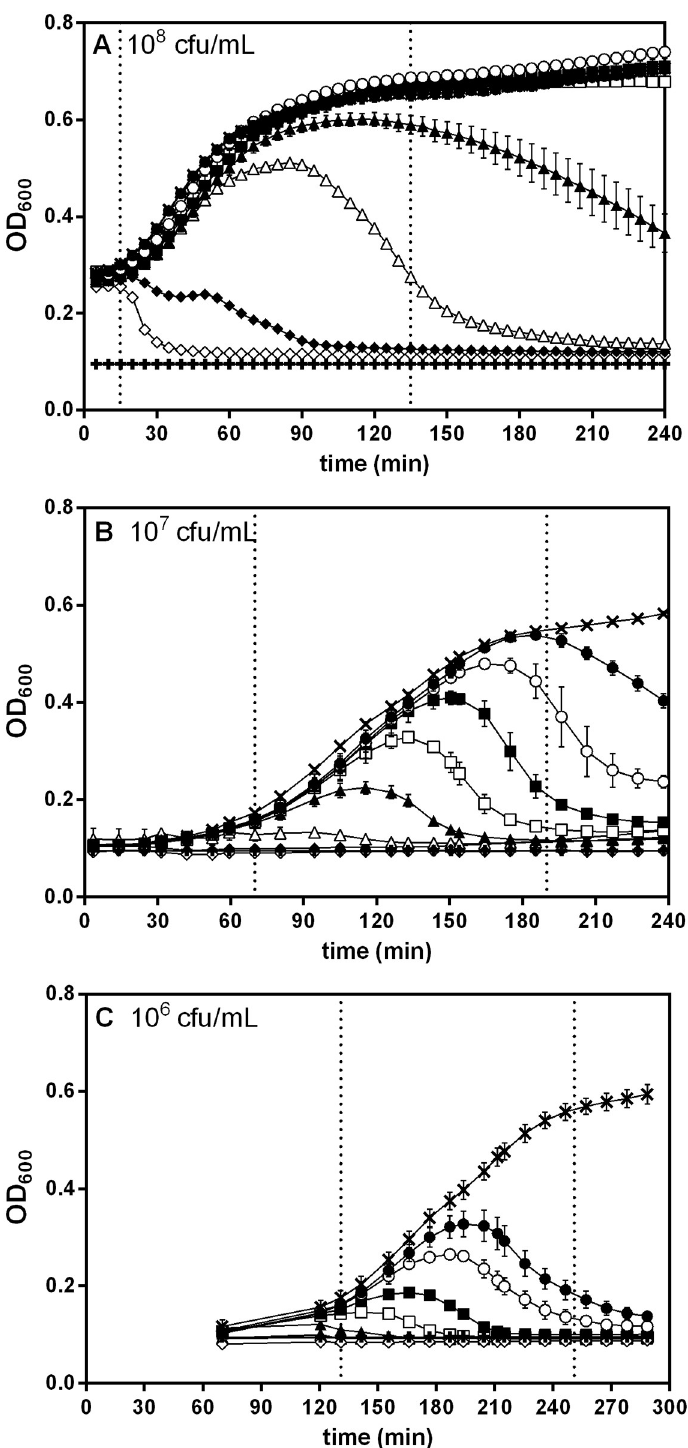
Fig 2. Evolution of optical density during time in cultures of E . coli exposed to different T4 phage concentrations. Several bacteria concentrations: A ) 10 8 , B ) 10 7 and C ) 10 6 were tested against different phage concentrations: 5x10 8 ( ◇ ), 5x10 7 ( ◆ ), 5x10 6 ( 4 ), 5x10 5 ( ▲ ), 5x10 4 ( □ ), 5x10 3 ( ■ ), 5x10 2 ( � ), 5x10 1 pfu/ml ( ● ) and without phages ( × ). Error bars represent the standard deviation (n = 3).